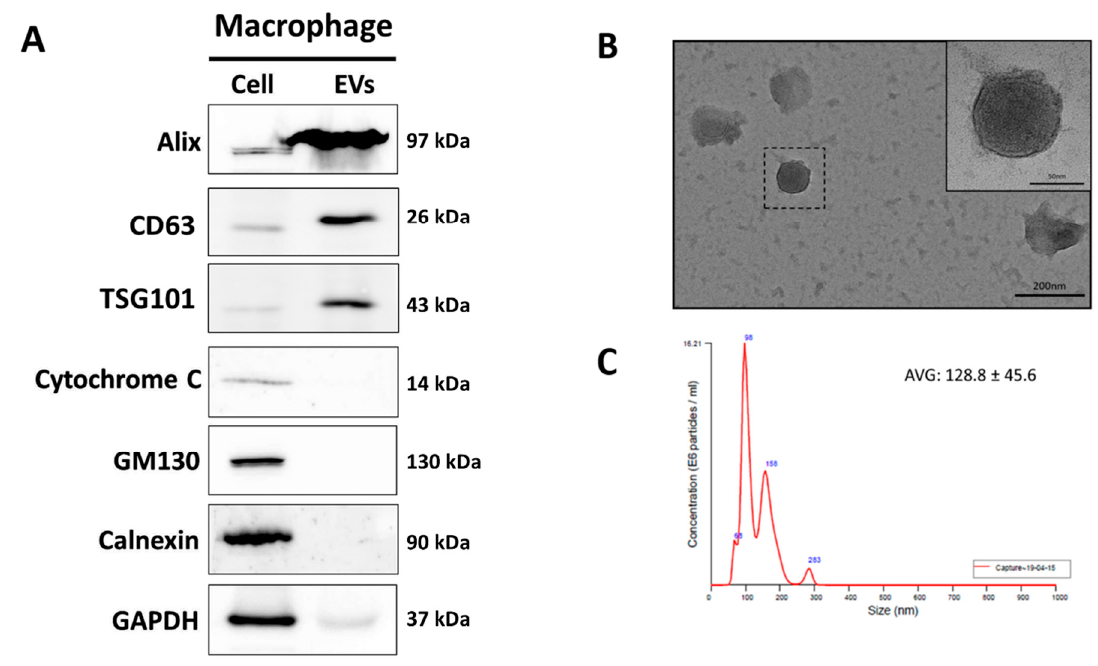
Figure 1. Successful isolation and characterization of MAC-EVs. ( A ) Western blot analysis of cell compartment markers of macrophages (cell) and MAC-EVs (EV). ( B ) Morphology of MAC-EVs confirmed by transmission electron microscopy (scale bar: 50 and 200 nm). ( C ) Size of MAC-EVs determined by NTA (average diameter: 128.8 ± 45.6 nm). EV: Extracellular Vesicles.